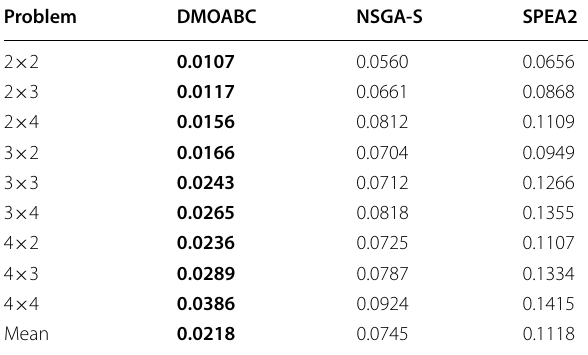
The optimal values are set in bold font among these three algorithms Table 7 D -metric comparison for DMOABC, NSGA-II, and SPEA2